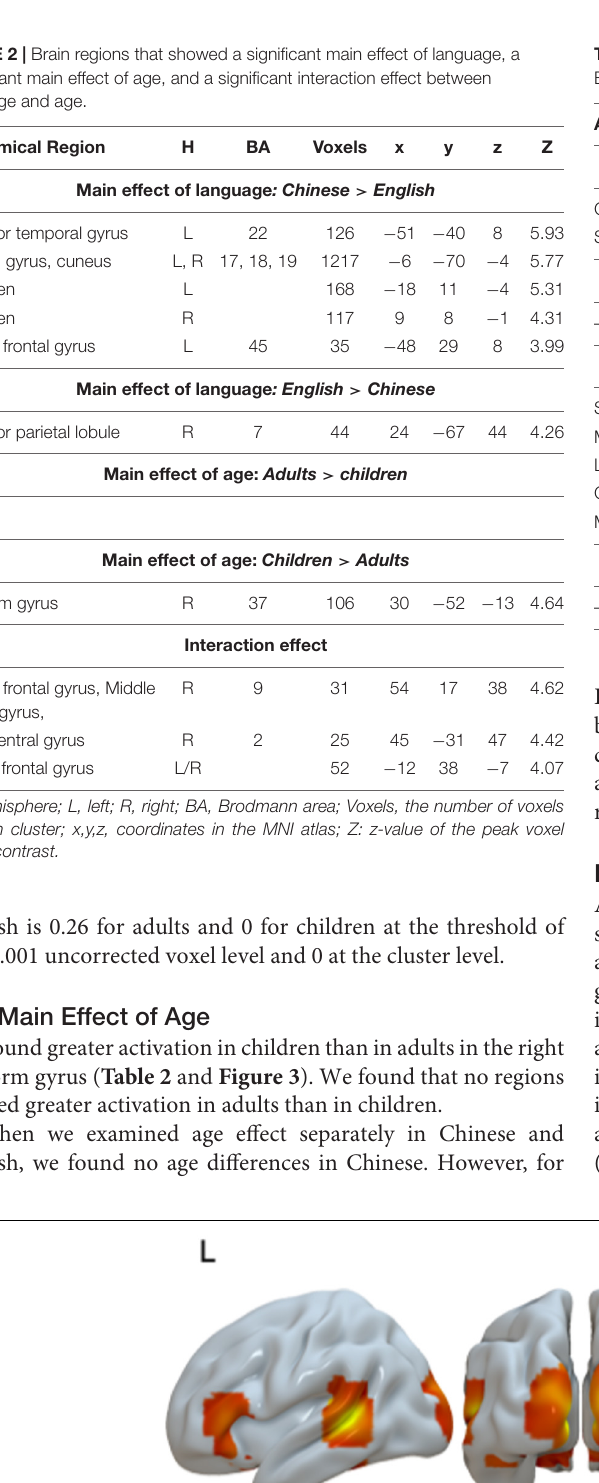
Frontiers in Neuroscience |